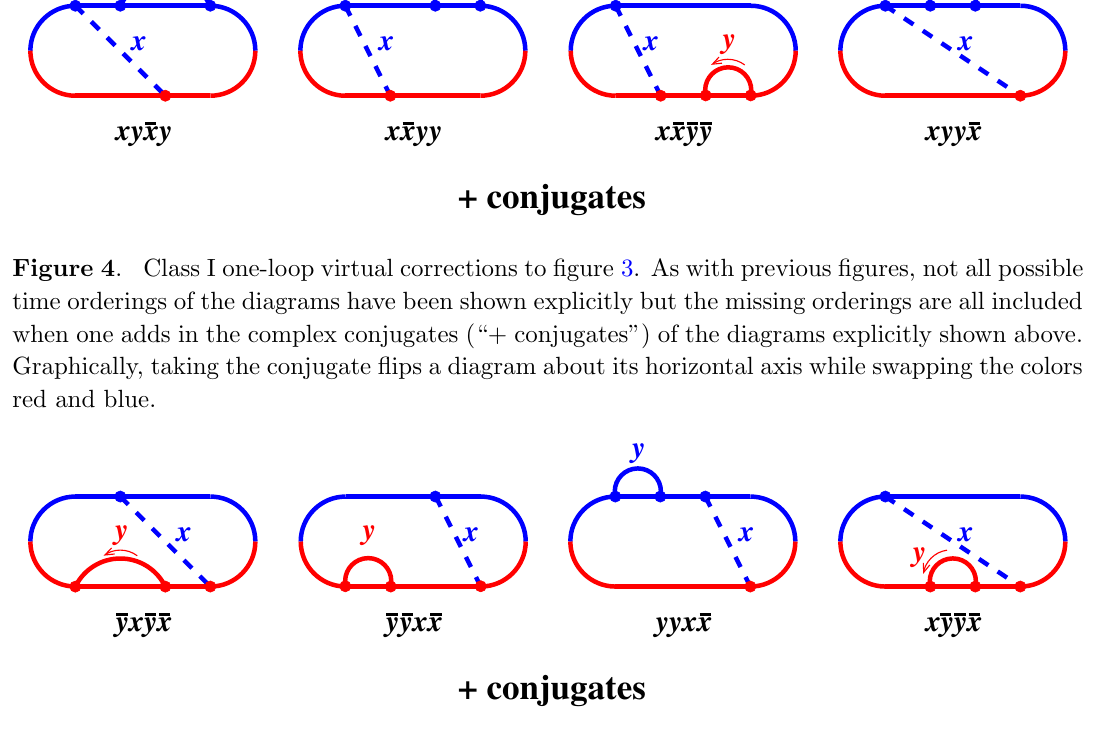
Figure 5 . Class II one-loop virtual corrections to (cid:12)gure